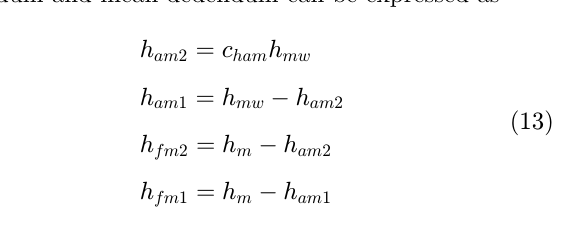
Fig. 2. Effect of dedendum angle on tooth